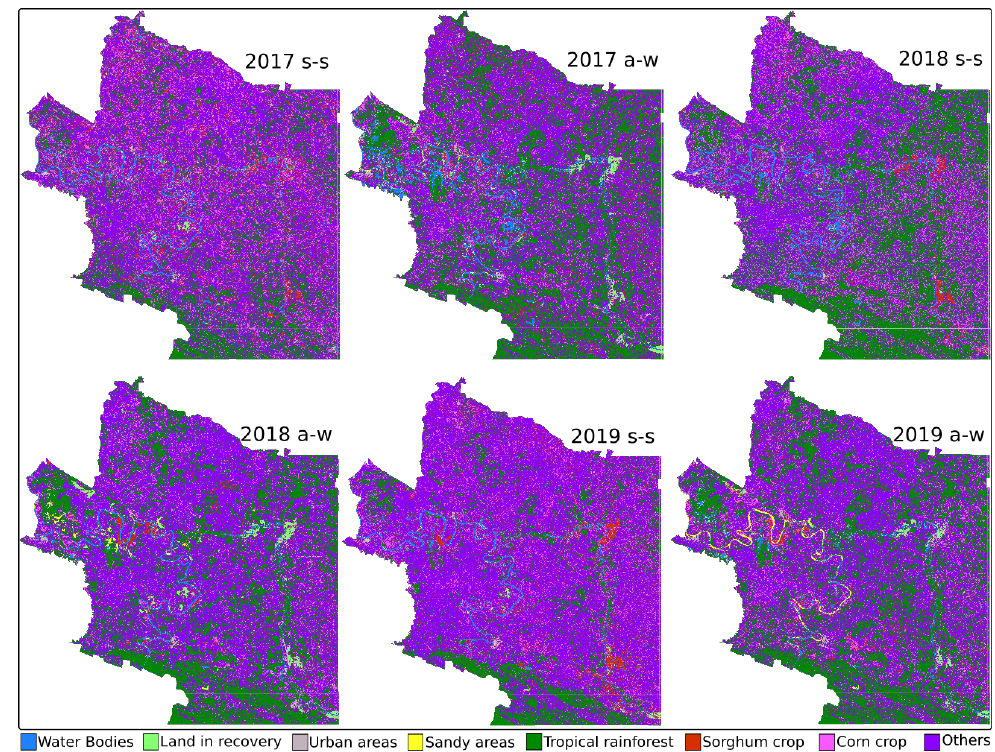
Figure 6. CART-generated maps. Table 9. Land-use coverage classified by CART. Coverage in